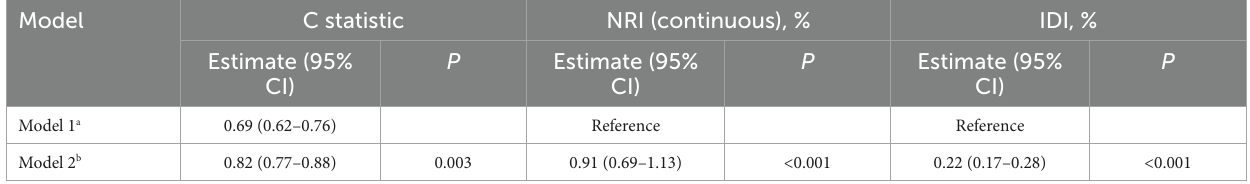
TABLE 4 Discrimination and reclassification statistics for unfavorable 90-day outcome by circulatory nTreg/mTreg ratio.